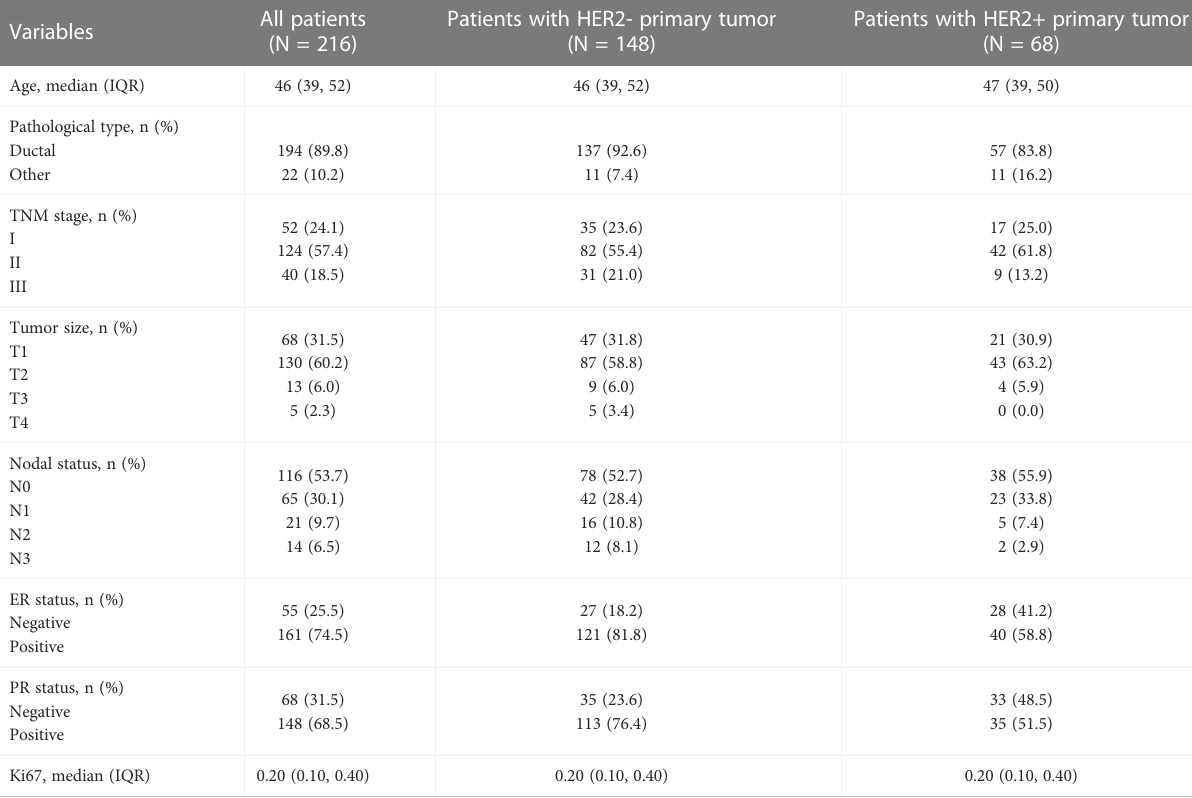
TABLE 1 Clinicopathologic parameters of 216 early breast cancer patients.